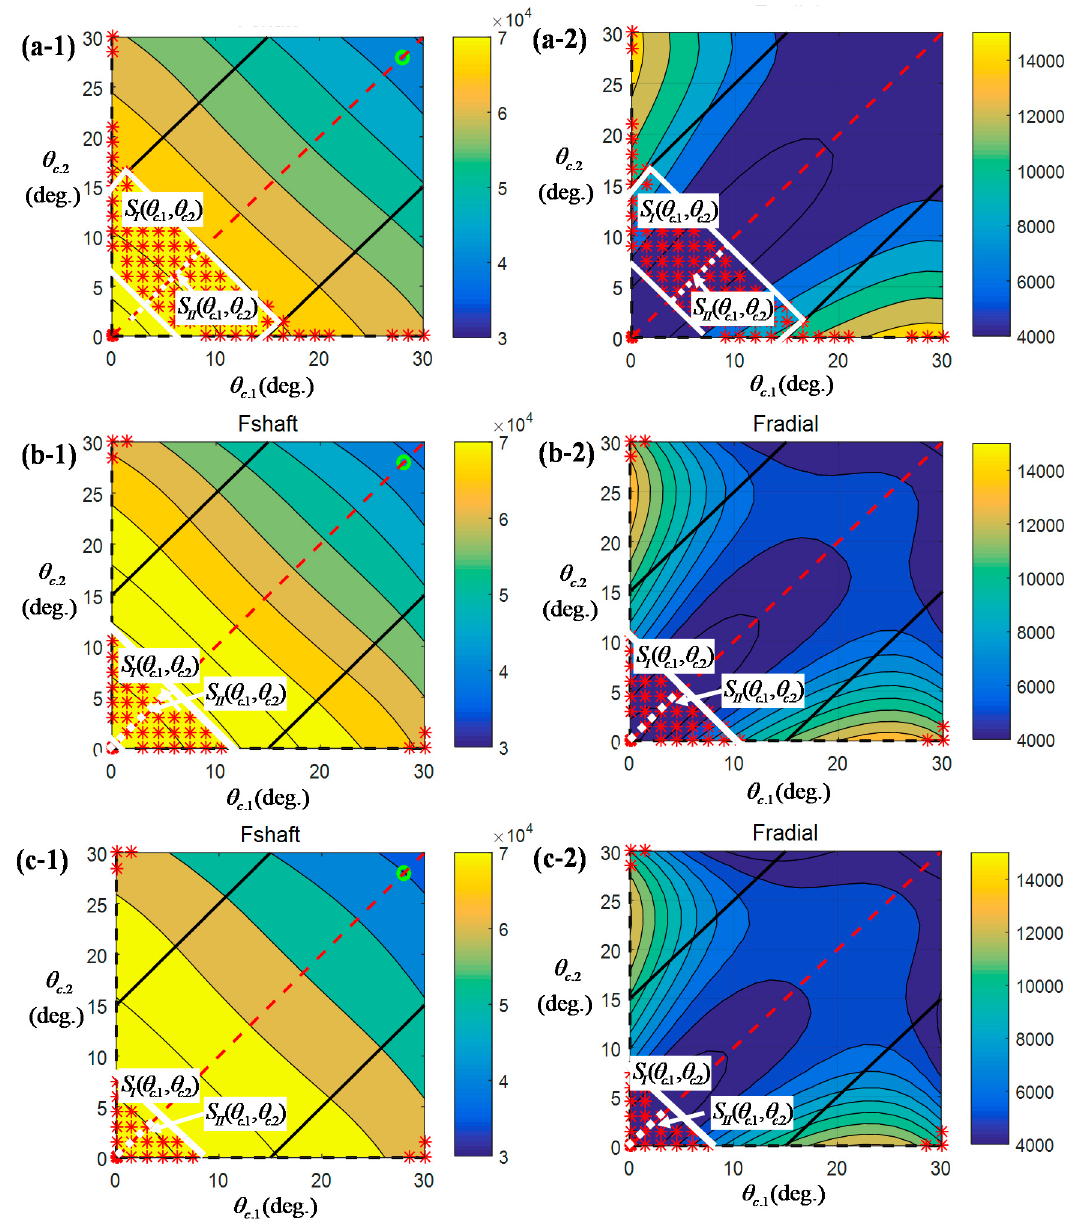
Figure 10. Average steady-state radial and axial forces, F ave . radial ( θ c .1 , θ c .2 ) and F ave . axial ( θ c .1 , θ c .2 ) , on bearing with various wind speeds (( a-1 ) and ( a-2 ) for V m = 16 m / sec, ( b-1 ) and ( b-2 ) for V m = 18 m / sec, ( c-1 ) and ( c-2 ) for V m = 20 m / sec ).